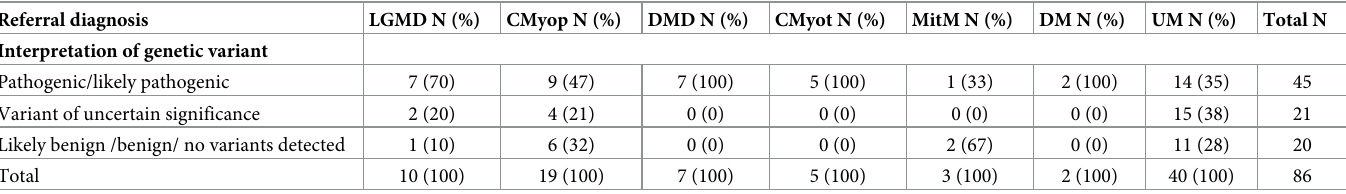
Table 2. Diagnostic yield in patients grouped according to referral diagnosis.